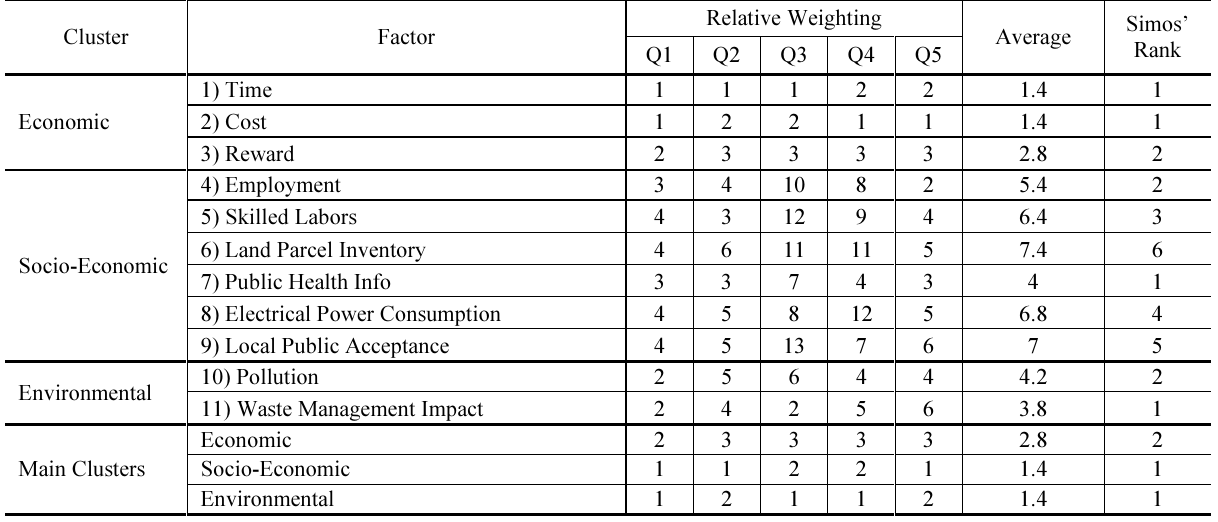
Table 4. Determining relative weights of factors/criteria